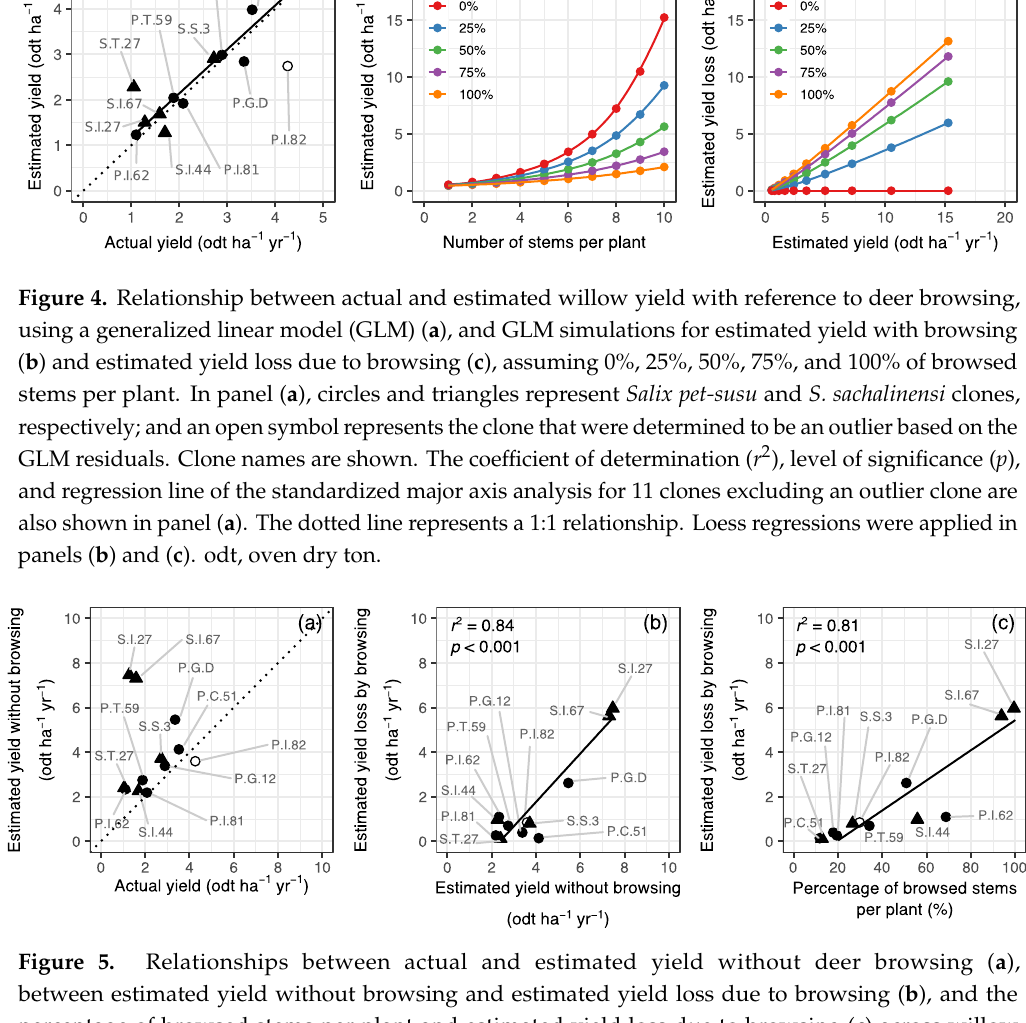
are also shown in panel ( a ). The dotted line represents a 1:1 relationship. Loess regressions were applied in panels ( b ) and ( c ). odt, oven dry ton.